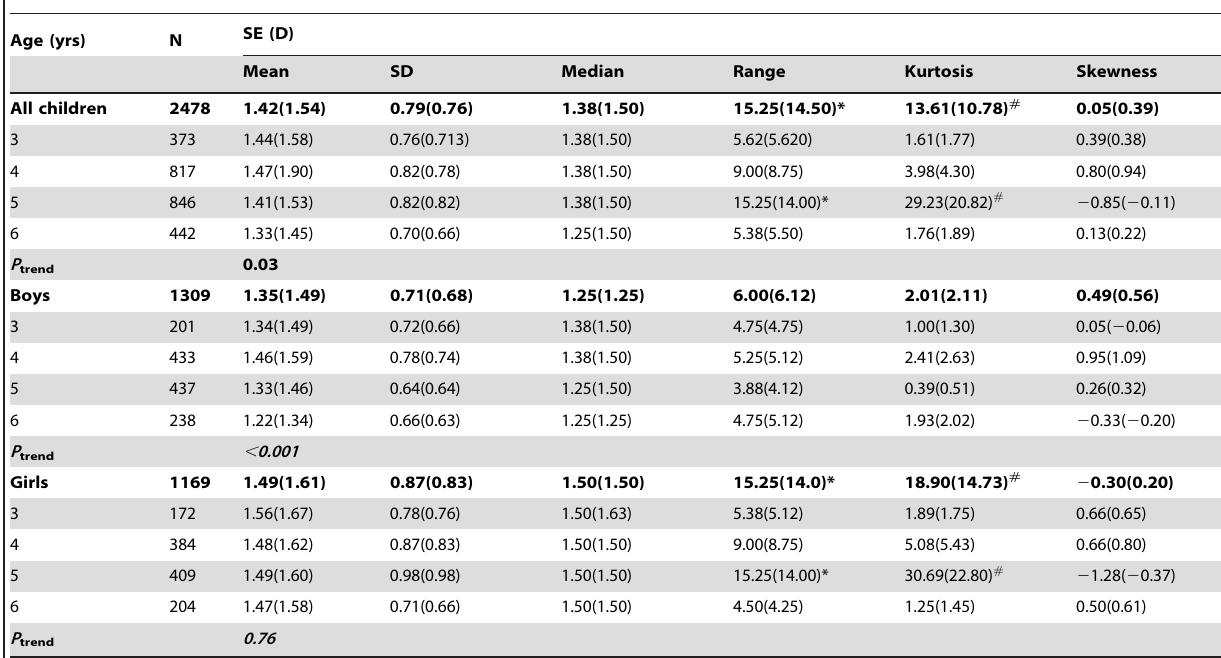
Table 2. Spherical Equivalent (SE) in Right Eyes Determined by Autorefraction and Retinoscopy.